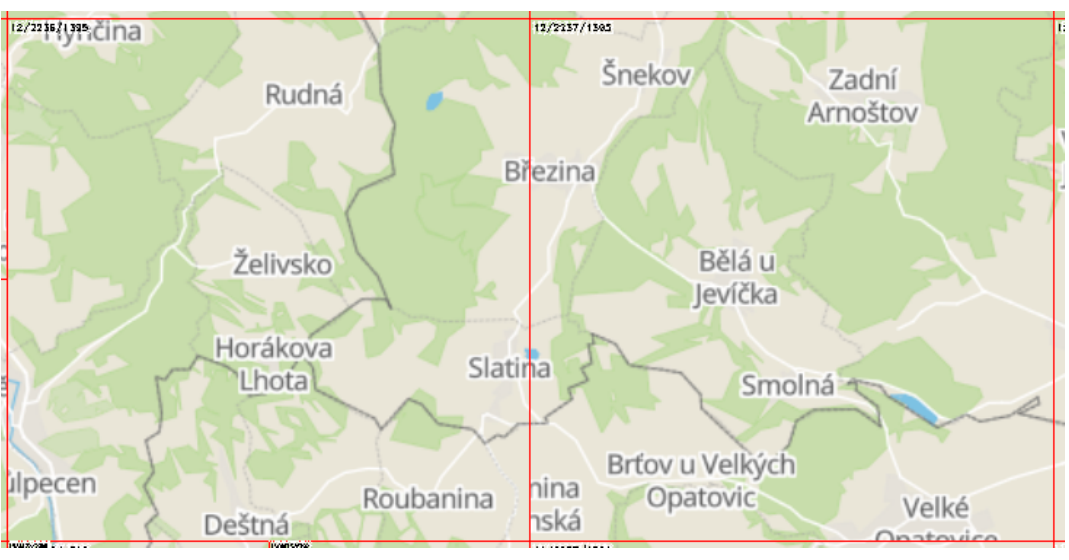
Figure 14. Visual appearance of raster tiles during fast zoom interaction.